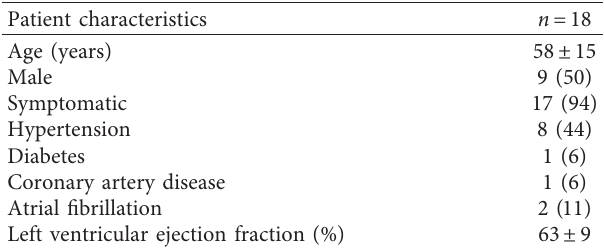
Data are presented as mean ± SD or n (%). PVC, premature ventricular contraction; ASV, aortic sinus of Valsalva; LVOT, left ventricular outflow